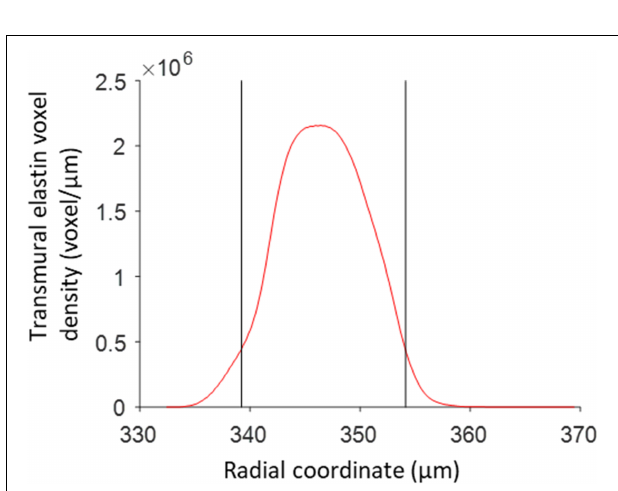
FIGURE 3 | Determination of vessel centerline from elastin voxels. (A) Definition of the vector point along the vessel centerline, defined by orientation unit vector centerline is determined by optimizing centerline for the elastin voxels 1, 2, and 3 are shown in black and red, respectively.